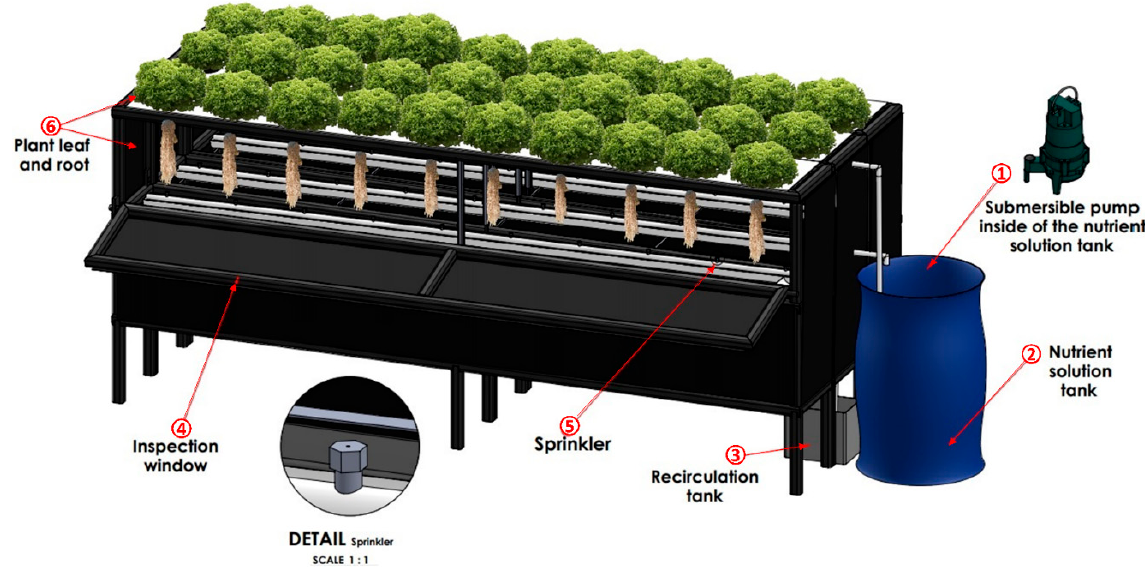
Figure 1. Aeroponic growth chamber.